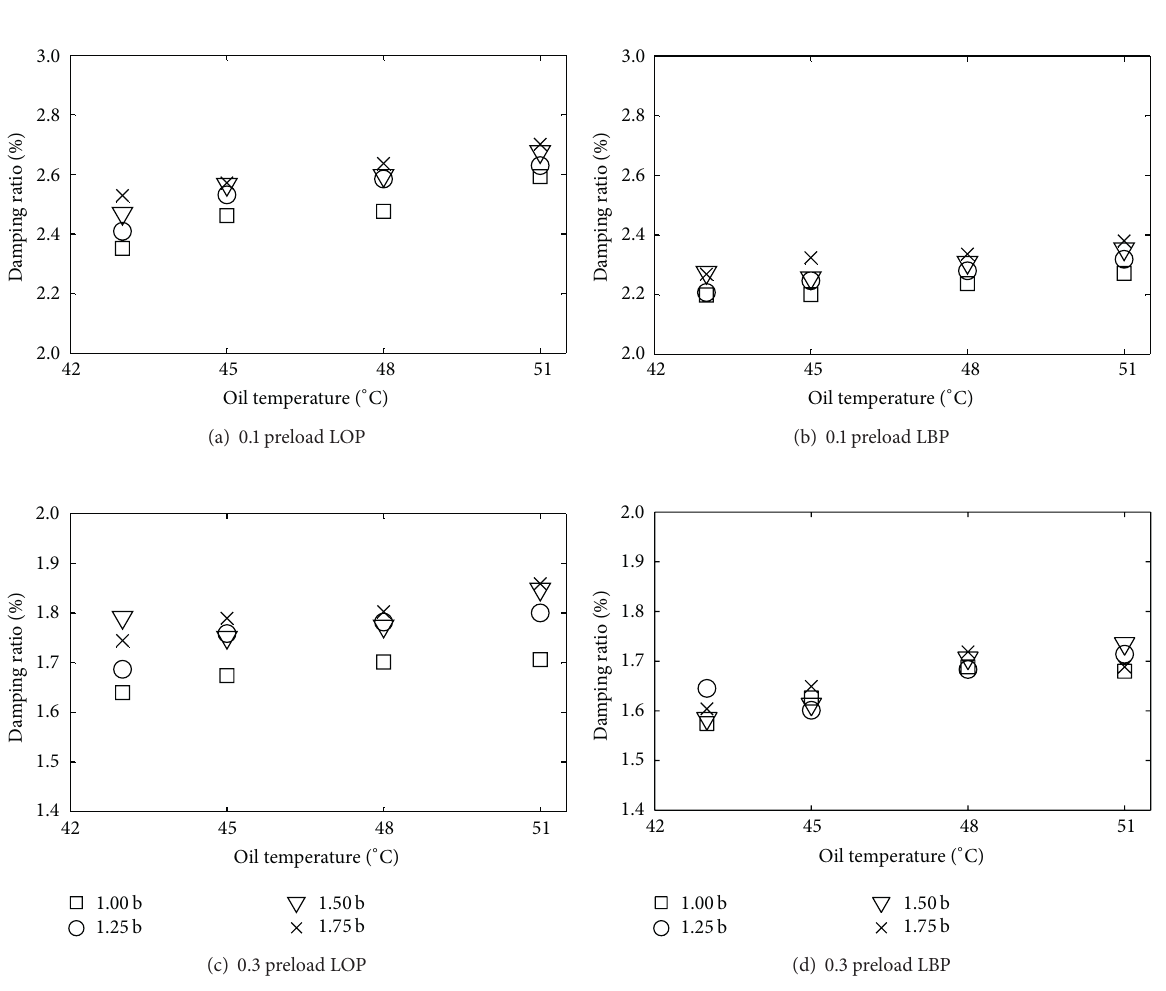
Figure 17: Effect of oil inlet temperature on the stability of